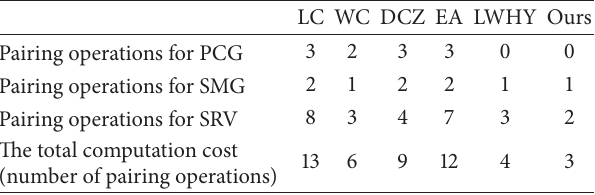
Table 2: Performance efficiency comparison in terms of the total number of pairing operations required among proxy signcryption